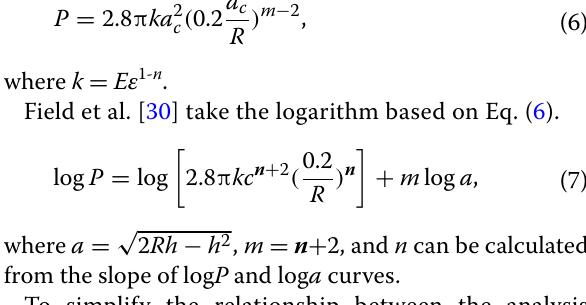
Figure 2 A schematic diagram of indentation profile